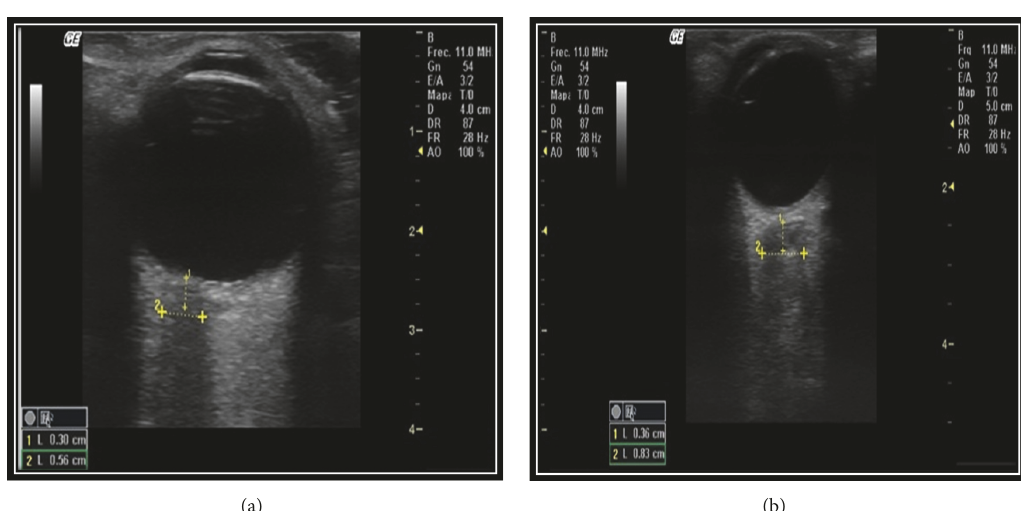
Figure 3: Ocular ultrasonography, mode B, with measurement of the optic nerve sheath, suggestive of endocranial hypertension, (a) transverse view, and (b) sagittal